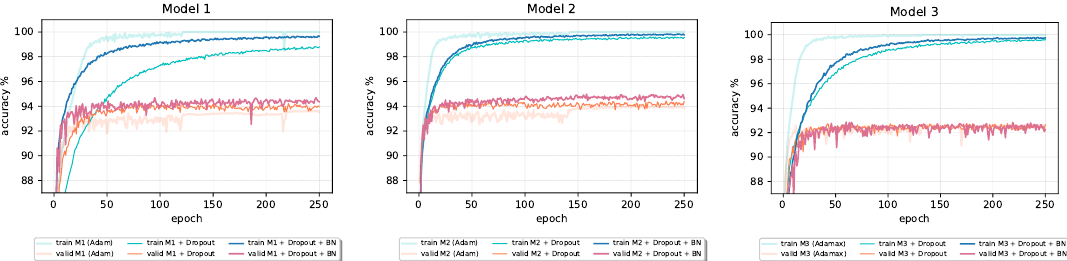
Figure 14. The effect of the Batch Normalization on the accuracy of models trained on the Fashion-MNIST dataset that incorporate Dropout regularization.